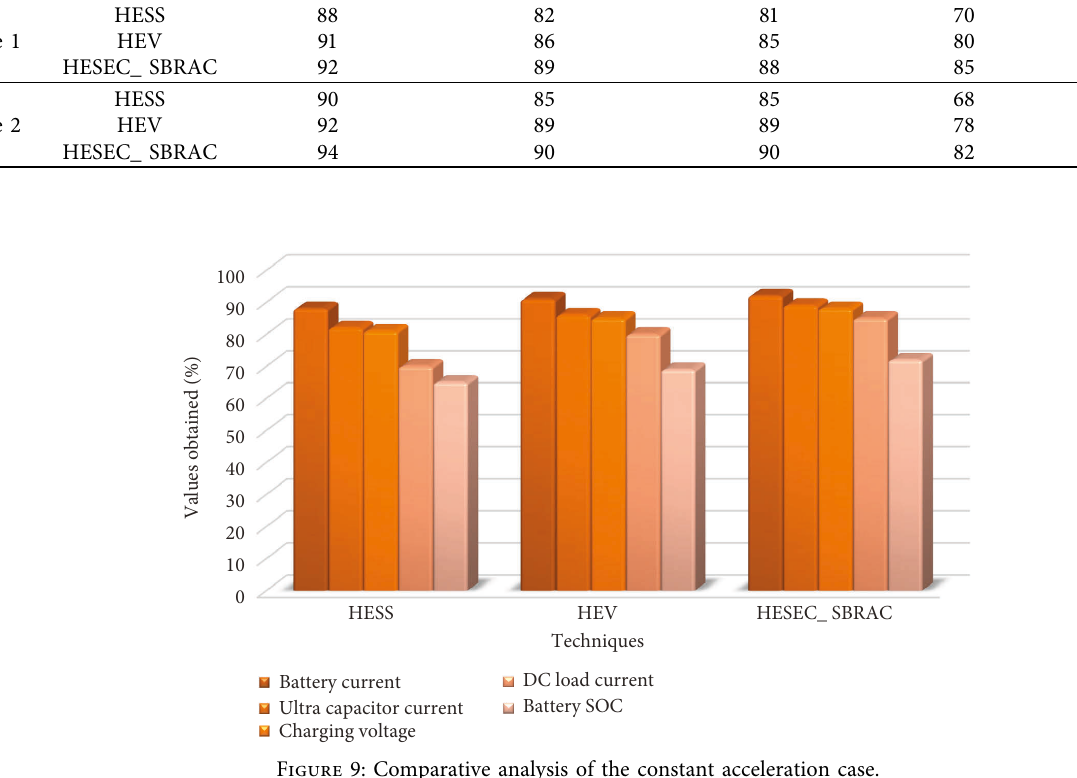
Table 6: Comparative analysis is based on the constant acceleration case and the time varying acceleration case.